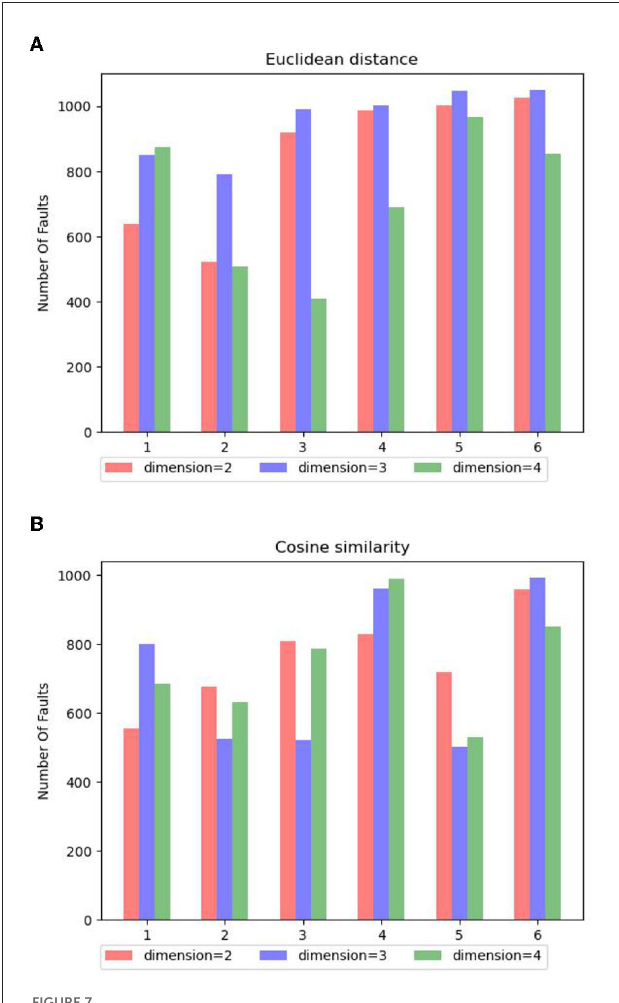
FIGURE7 (A) The number of fault samples selected according to Euclidean distance in different dimensions. (B) The number of fault samples selected according to cosine similarity in different dimensions.